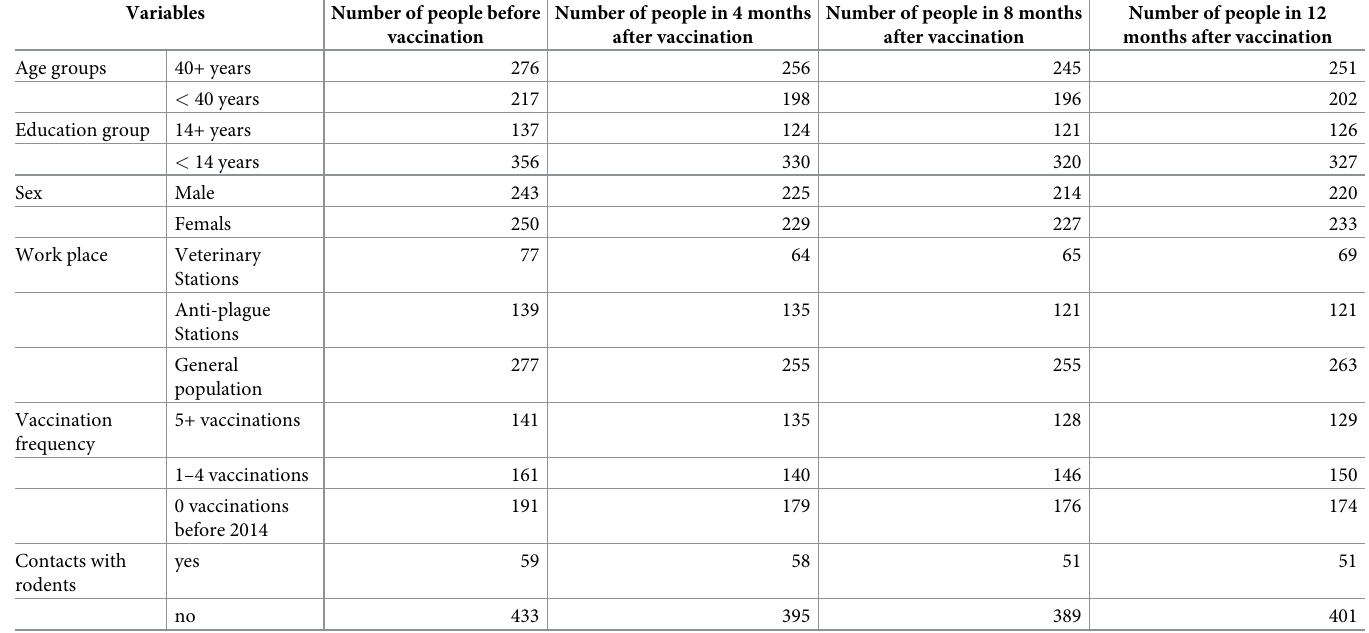
Table 1. People participated in the